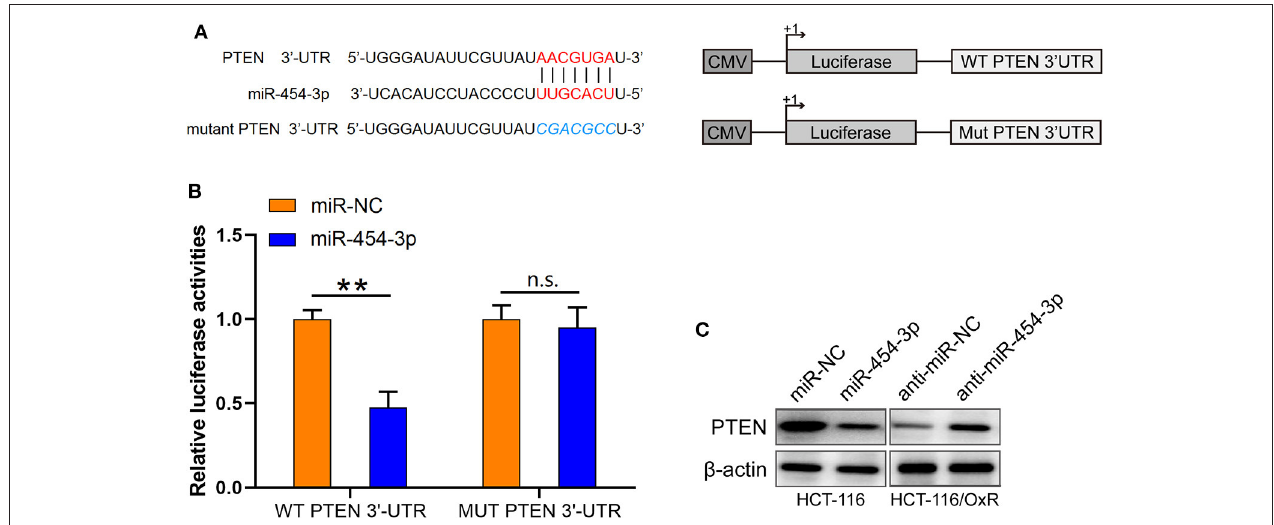
FIGURE 3 | PTEN is a target of miR-454-3p. (A) Predicted miR-454-3p binding site in the 3 ′ -UTR of PTEN. (B) Luciferase reporter assay confirmed that miR-454-3p bound to 3 ′ -UTR of PTEN. (C) Western blotting assay showed the protein level of PTEN after overexpression or knockdown of miR-454-3p. ** P <